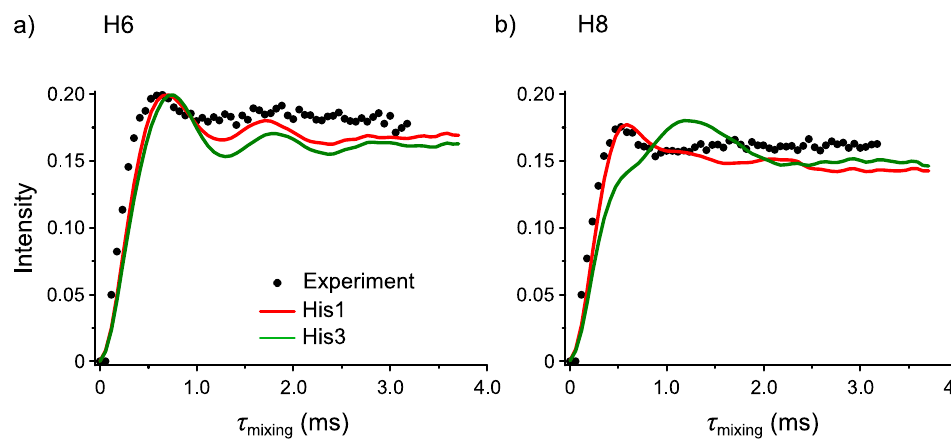
Figure 5. Comparison of the experimental 1 H- 1 H selective recoupling of proton (SERP) build-up curve (black circle) with the simulated curves from His1 (red) and His3 (green) for selective transfer between ( a ) NH-H6 and ( b ) NH-H8.